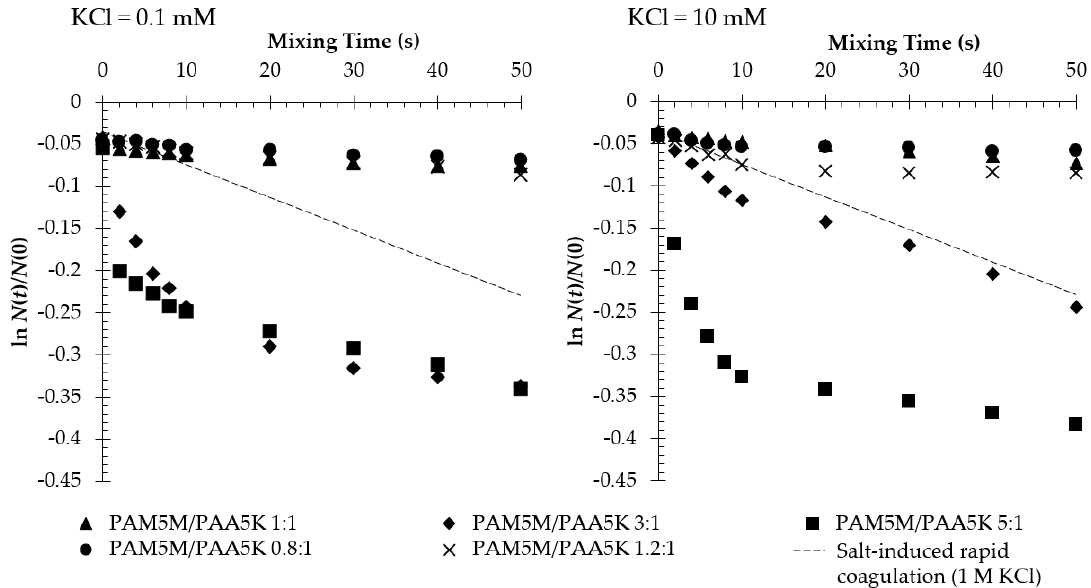
Figure 6. Temporal variation of polycation-induced flocculation rate in 0.1 mM and 10 mM KCl determined in the presence of 0.5 mg/L PAA5K.